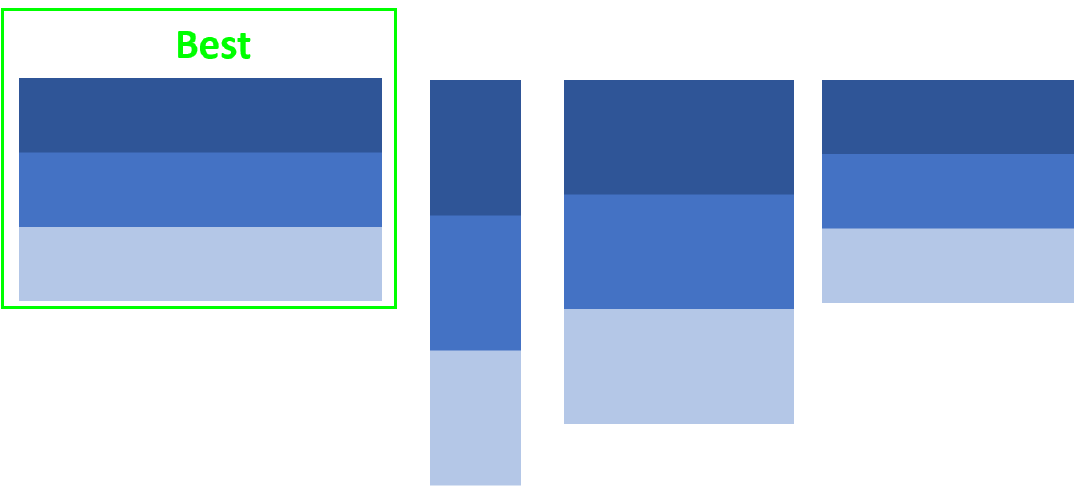
Figure 11. An example of the insertion of the best individual into the new random